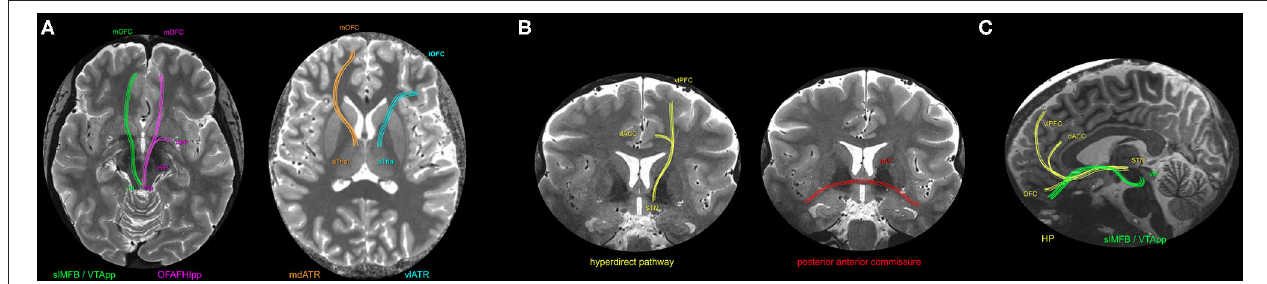
FIGURE 2 | Schematic representation of the WMP possibly modulated by DBS in OCD patients, overlaid in a 7T MP2RAGE T1 map (Siemens, Magnetom, Germany, from PISA - FMUSP, São Paulo). (A) Axial planes representing four WMP: In green, the superolateral middle forebrain bundle (slMFB) - named afterwards as ventral tegmental area projection pathway (VTApp) - projects from the ventral tegmental area (vta) to mOFC (medial orbitofrontal cortex) in a ventral level (21, 23). In pink, the orbitofrontal amygdalofugal habenulo-interpeduncular pathway (OFAFHIpp), from the vta to amygdala and mOFC, was mentioned in (39). In orange, the medial dorsal anterior thalamic radiation (mdATR), from anterior thalamus to mOFC, was cited in (17, 20, 23, 37). In blue, the ventrolateral anterior thalamic radiation (vlATR), mentioned in (17, 21, 37). (B) Coronal plane, representing two WMP: In yellow, the hyperdirect pathway (HP) comprises fibers from the subthalamic nucleus (STN) to both dorsal anterior Cingulate cortex (dACC) and ventrolateral prefrontal cortex (vlPFC) (22, 38, 39). In red, the posterior limb of the anterior commissure, connecting bilateral temporal cortices (22). (C) Sagittal plane, representing two of the above mentioned WMP: slMFB/VTApp and the HP, to optimize the 3D